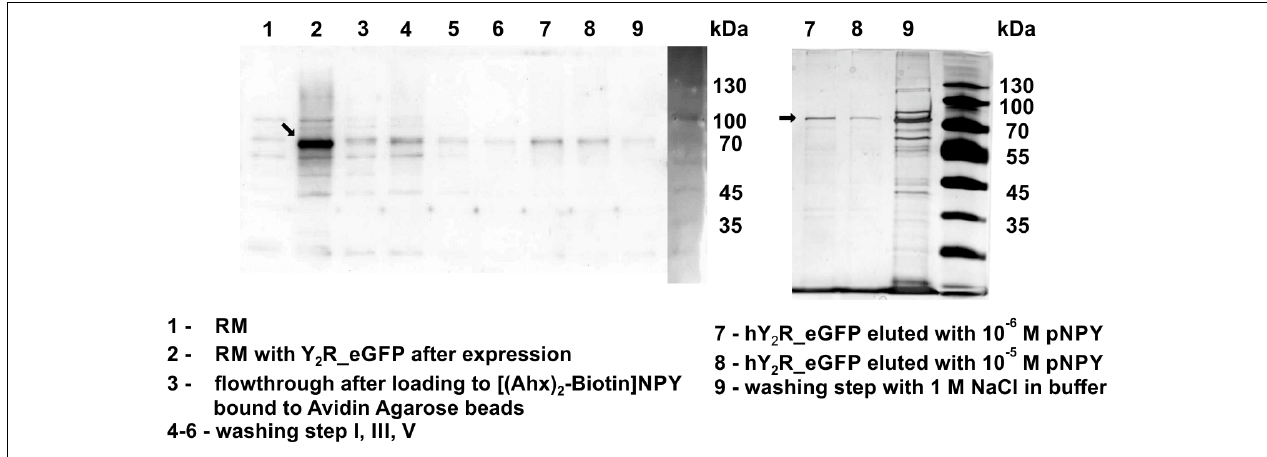
FIGURE 2 | Western Blot (left) and silver staining (right) of cell-free expressed hY 2 R_eGFP before and after ligand affinity chromatography. The reaction mix (RM) was plotted before (1) and after (2) expression of Y 2 R_eGFP to determine a successful protein expression. Next, RM was added to biotin-(Ahx) 2 -NPY loaded columns (3) and unfolded/not correctly folded Y 2 R_eGFP was washed away by multiple washing steps (4–6). Next, correctly folded receptor was eluted specifically by adding an excess of NPY, Y 2 R_eGFP is represented by one band in lane 7, 8. After specific elution, residual Y 2 R_eGFP was washed from column by 1 M NaCl in buffer (9). Arrows indicate Y 2